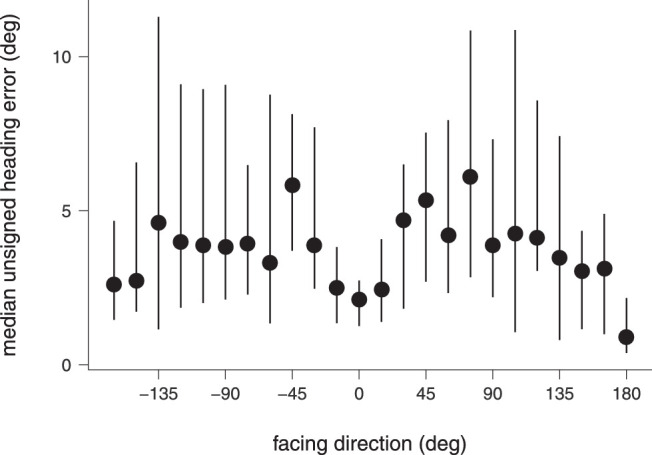
Median unsigned heading errors in the natural articulation-plus-translation condition for all facing directions. Error bars give the upper and lower interquartile ranges.